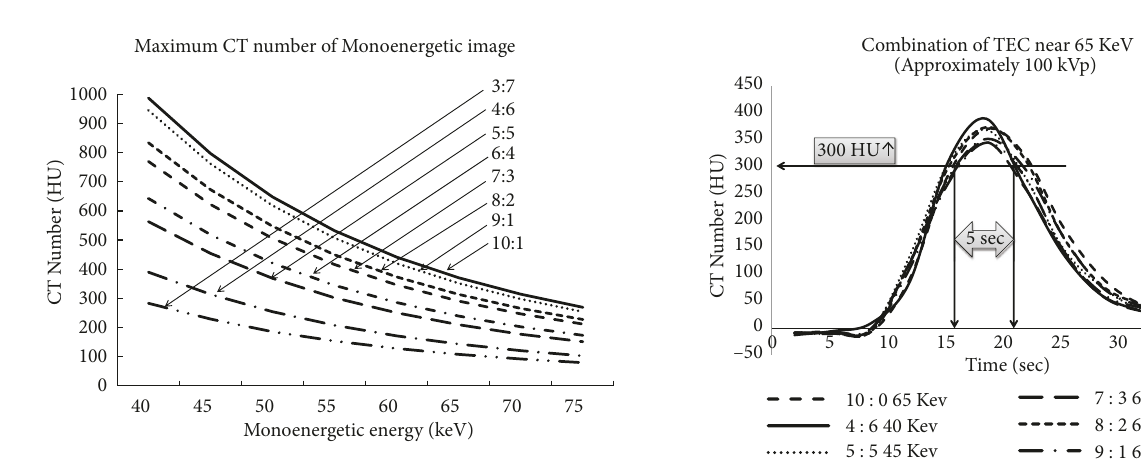
Figure 8: The maximum CT number per dilution rate. The maxi- mum CT number per each keV resulted in a higher number if the diluted ratiowas higher.If keVwas lower, the maximumCT number was higher. Finally, for 100% contrast (0% saline) at 40 kV, the CT number reached 1000 HU.